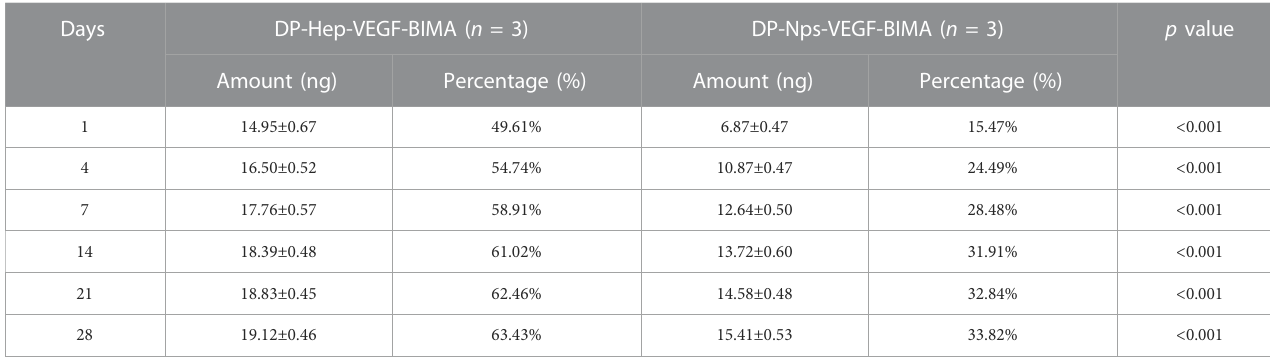
TABLE 2 In vitro release assay of